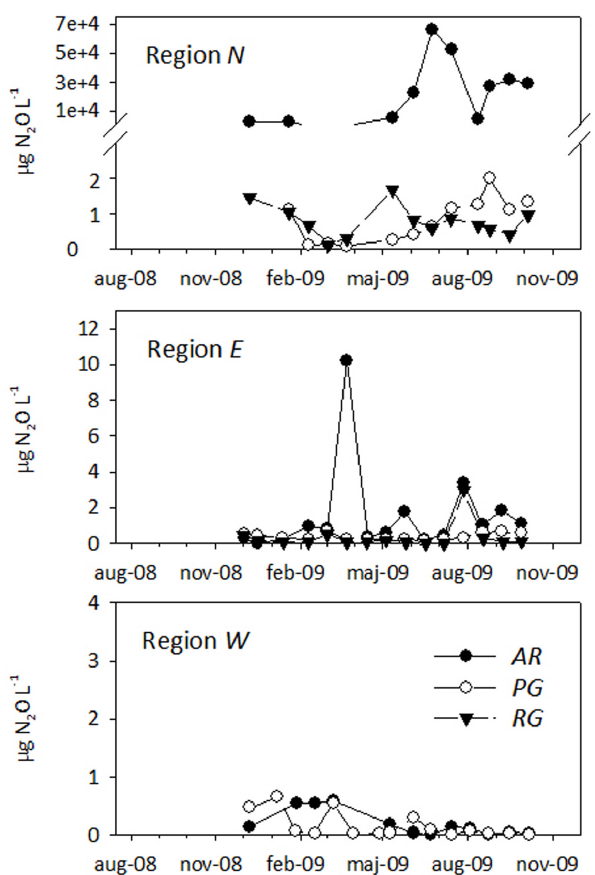
Fig. 6. Concentrations of N 2 O dissolved in the groundwater were determined in a central location at each of the eight monitoring sites using a silicone diffusion cell (see text) starting December 2008. Gas samples at equilibrium with the surrounding water were col- lected during gas flux measurement campaigns.